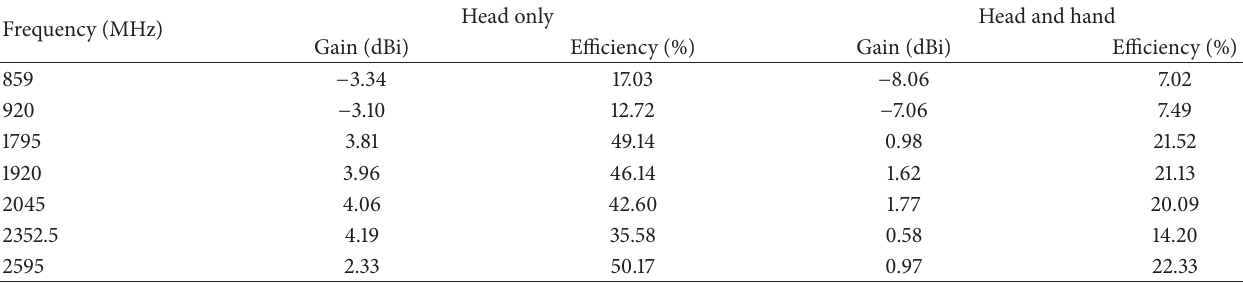
Table 3: Simulated gain and efficiency for the proposed antenna with the head and hand phantoms. Frequency (MHz)